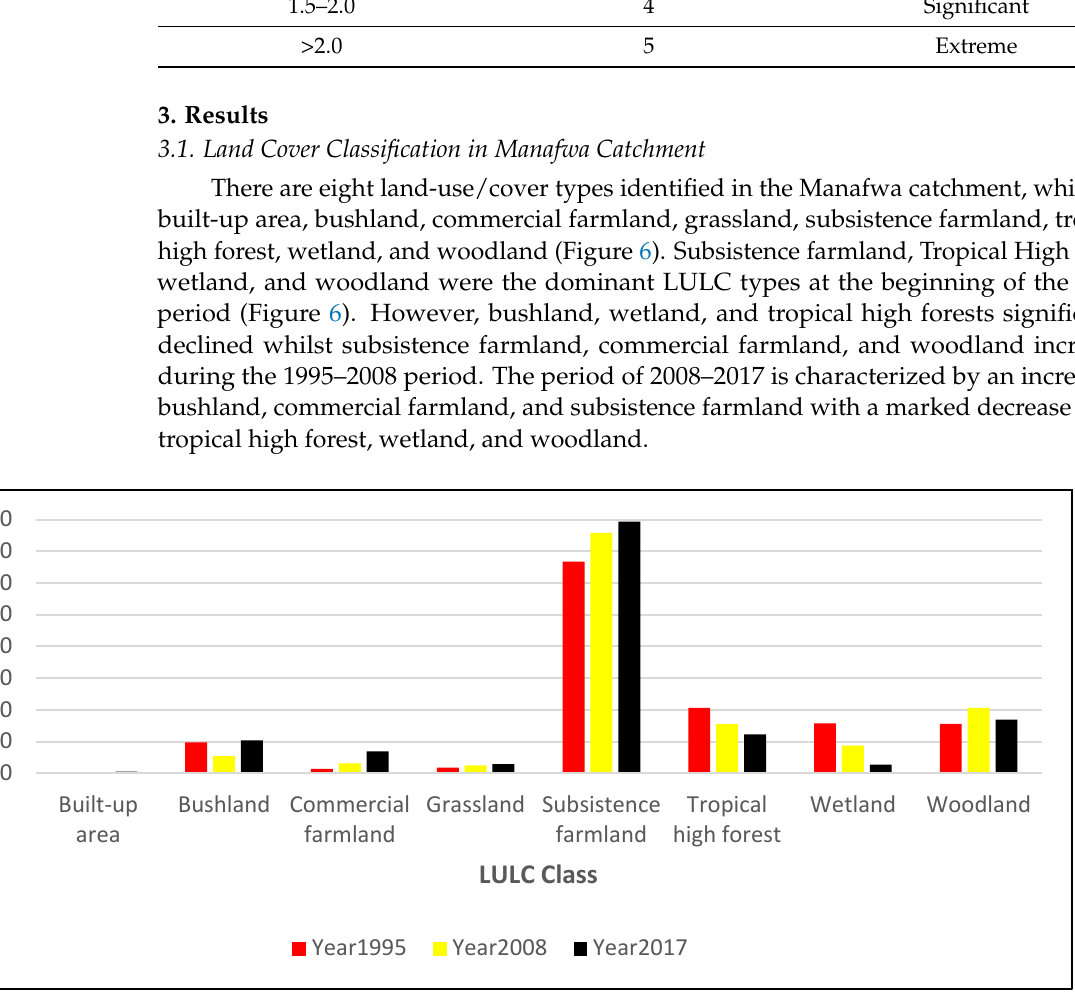
Figure 6. Temporal change of land cover types in Manafwa catchment between 1995 and 2017.